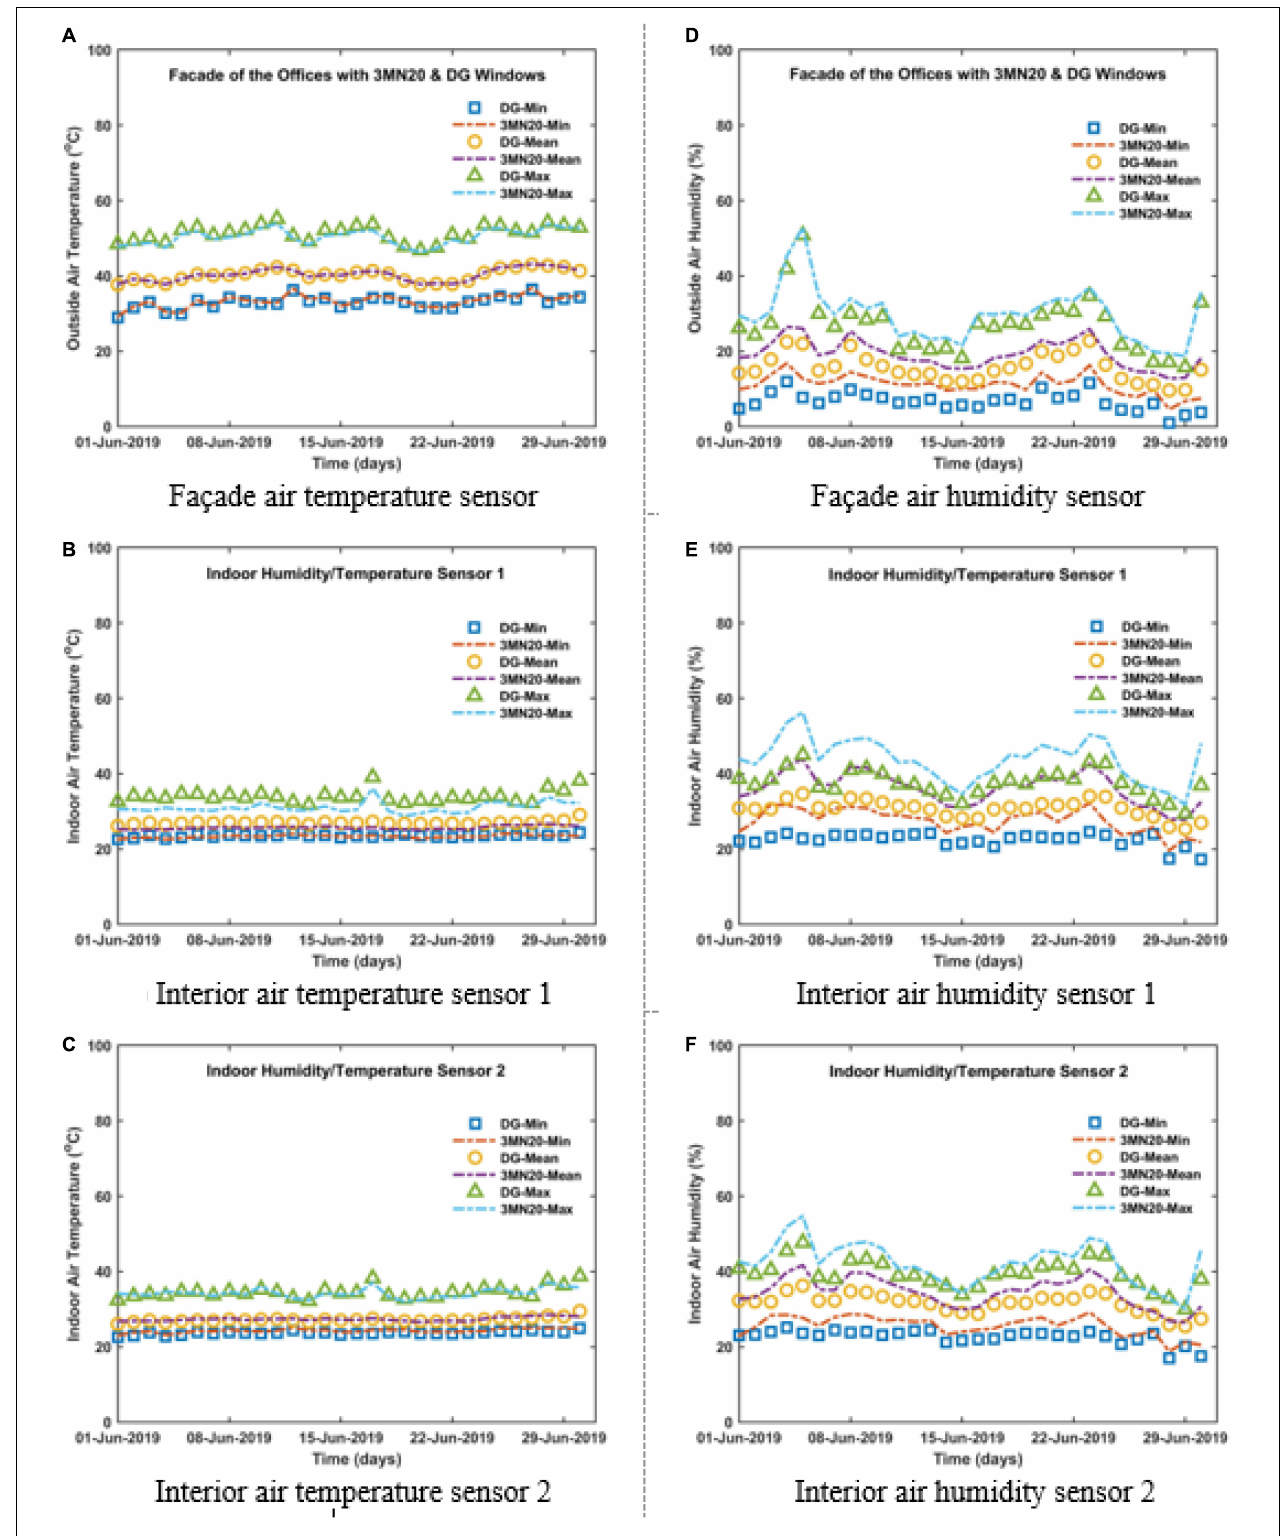
FIGURE 12 | Façade and interior air temperature and humidity for three DHT22 sensors for the offices with double glazing (DG) and 3M Neutral 20 (3MN20) windows during the month of June 2019; (A–C) temperatures, and (D–F) humidity variations.